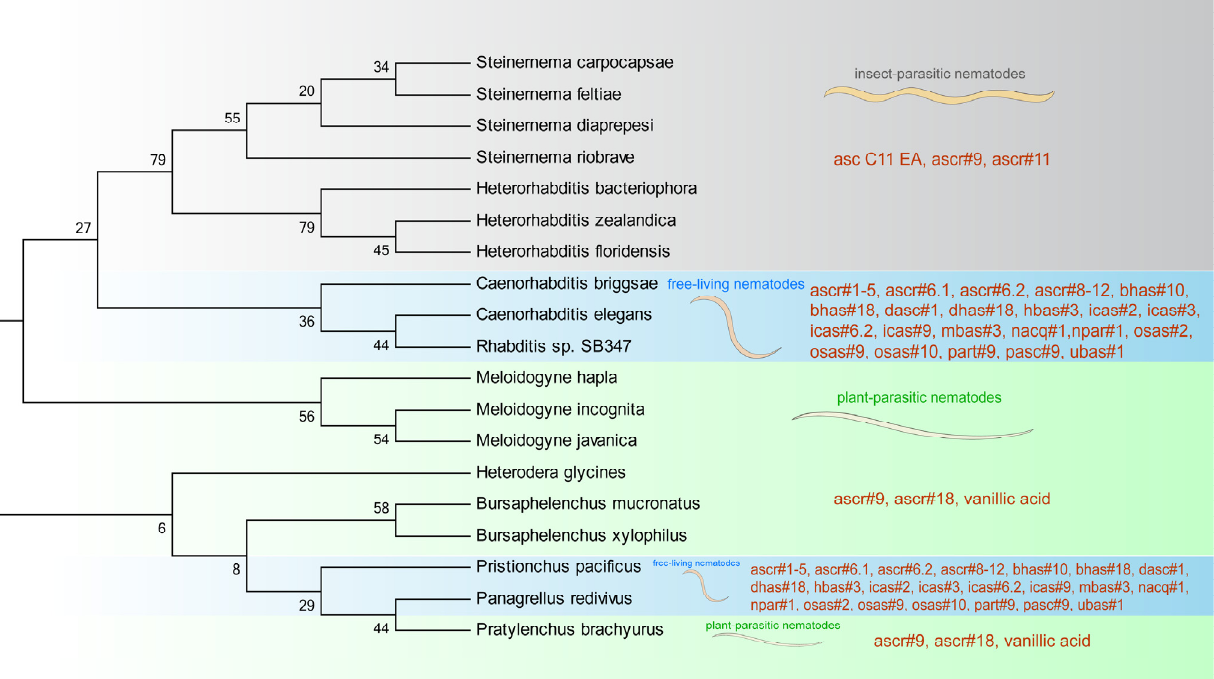
Figure 5. Pheromones are produced by a wide range of nematode species. The phylogenetic tree was drawn using Mega 4 software based on the comparison of 28S ribosomal RNA (28S) gene sequences obtained from GenBank. The nematodes can be classified into three categories including plant-parasitic nematodes (light green), insect-parasitic nematodes (light grey), and free-living nematodes (light blue). Diverse pheromones can be found widely among nematode groups (red).